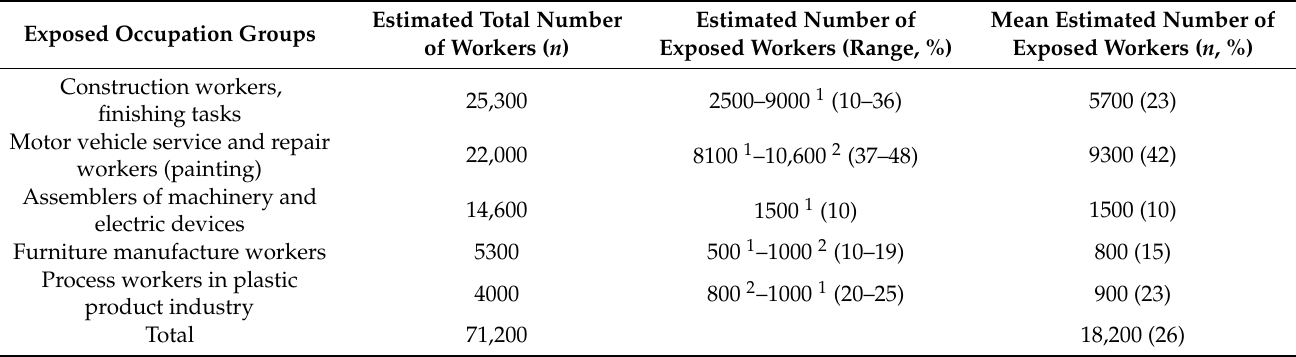
Table 2. Estimated number of workers exposed to diisocyanates in certain occupation groups in